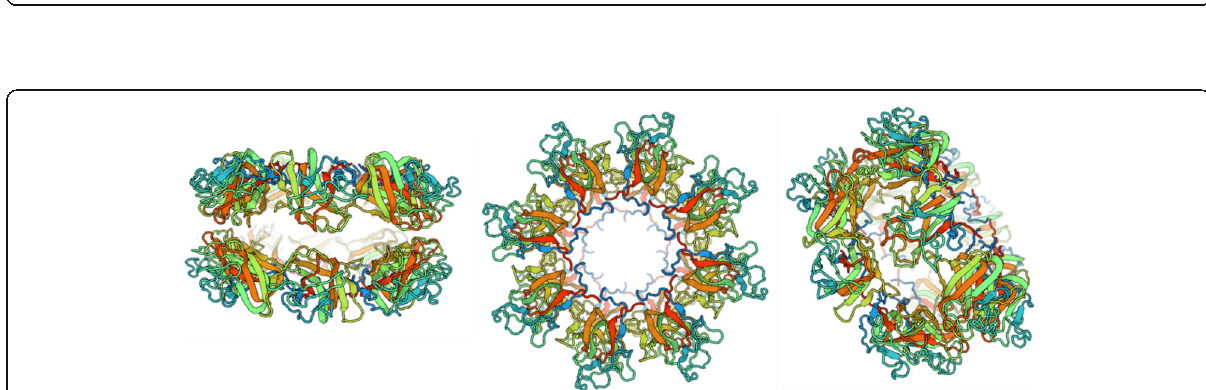
Fig. 5 a Protein models of reference RS1 (left) and mutant T138 N (right) proteins generated by the I-TASSER program. Red arrows denote obvious structural changes to protein structures. A white arrow highlights the position of the amino acid change at codon 138. b Protein model of RS1 mutant T138 N generated by STRUM. The affected amino acid residue is displayed in blue and annotated in red